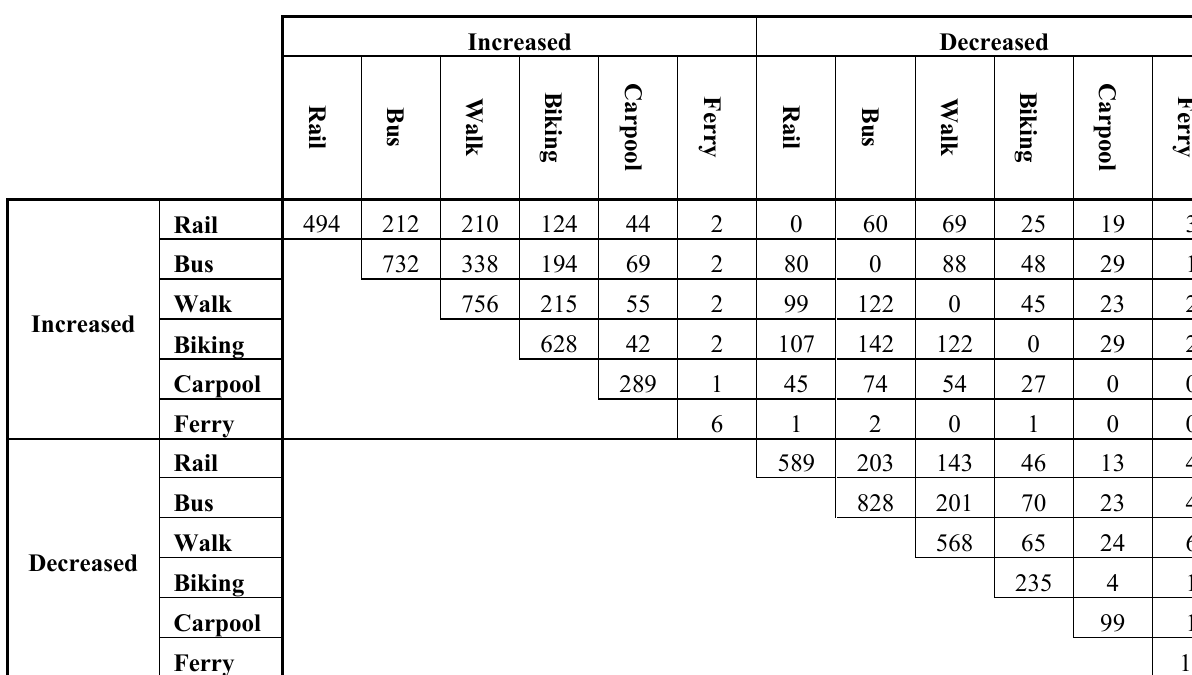
Table 4. Cross-Tabulation of Modal Shift